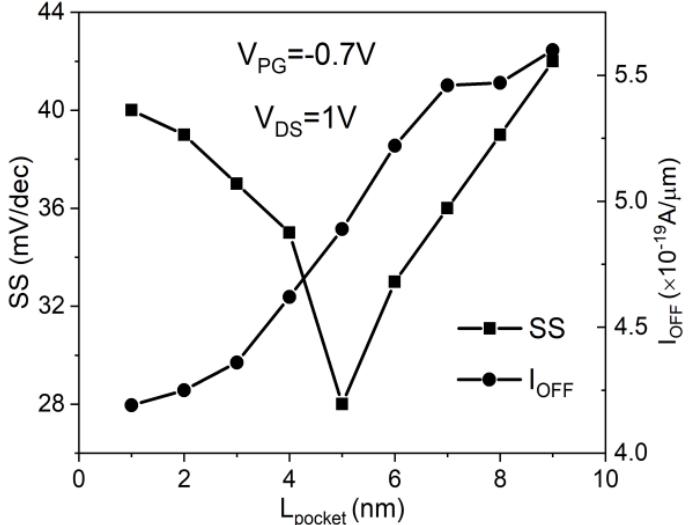
Figure 4. Average subthreshold swing (SS) and OFF -state current ( I OFF ) of the in-built N + pocket ED-TFET as a function of the length of the pocket ( L pocket ).